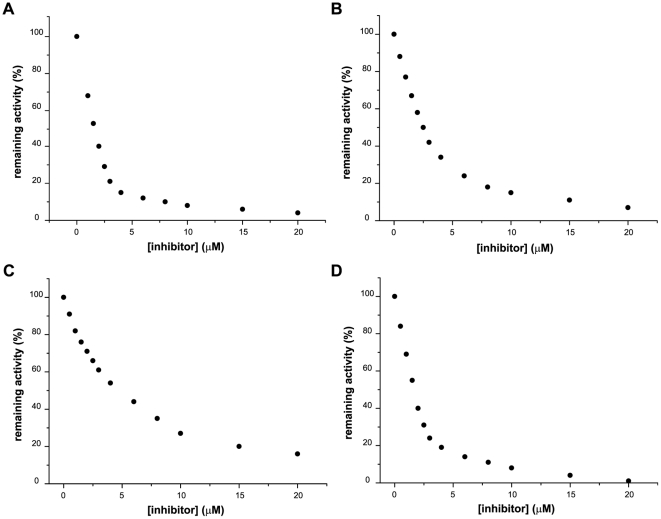
Inhibition of TR activity of TGR by active compounds.Remaining TR activity as a function of inhibitor concentration is plotted for a. 1, b. 2, c. 3 and d. 50. 1 nM TGR was used in all assays.